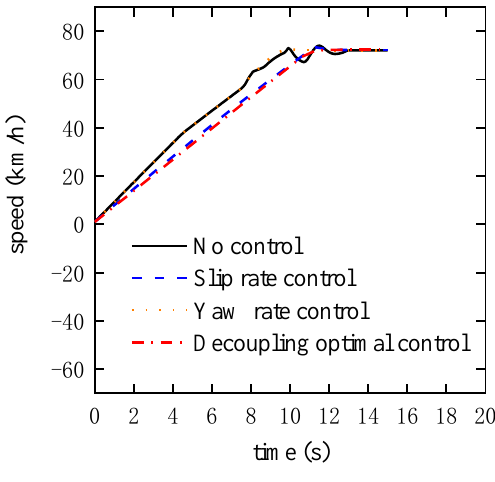
Figure 20. Vehicle speed.